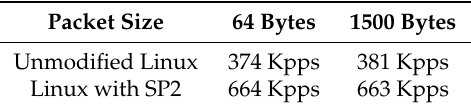
SP2 outperforms unmodified Linux by 74% and 77% for 64-byte and 1500-byte packets,